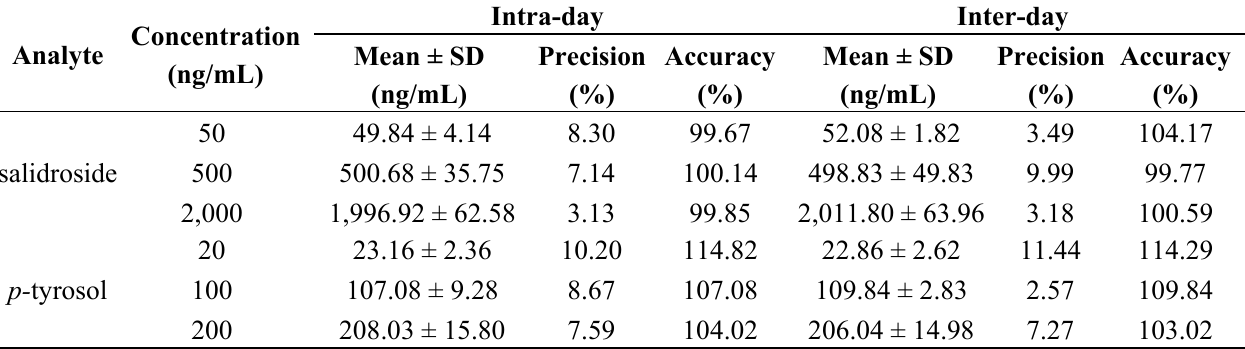
Table 2. Accuracy and precision for the determination of salidroside and p- tyrosol in plasma samples (n =